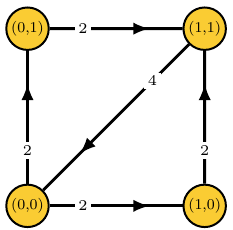
Figure 8. The quiver for phase 2 of F 0